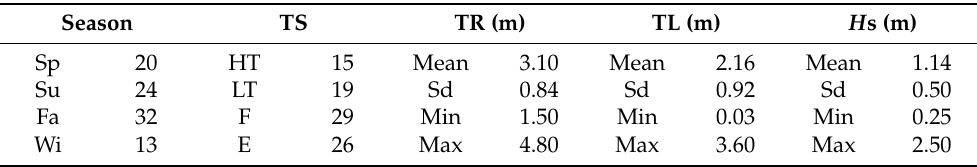
Table 2. Descriptive statistics of environmental conditions (TS: Tidal Stage; TL: Tidal Level; TR: Tidal Range; H s: significant wave height) associated with the 89 Sentinel-2 and Landsat-8 images. Season TS TR (m) TL (m) H s (m) Sp 20 HT 15 Mean 3.10 Mean 2.16 Mean 1.14 Su 24 LT 19 Sd 0.84 Sd 0.92 Sd 0.50 Fa 32 F 29 Min 1.50 Min 0.03 Min 0.25 Wi 13 E 26 Max 4.80 Max 3.60 Max 2.50 Sp: Spring; Su: Summer; Fa: Fall; Wi: Winter; HT: High Tide; LT: Low Tide; F: Flood; E: